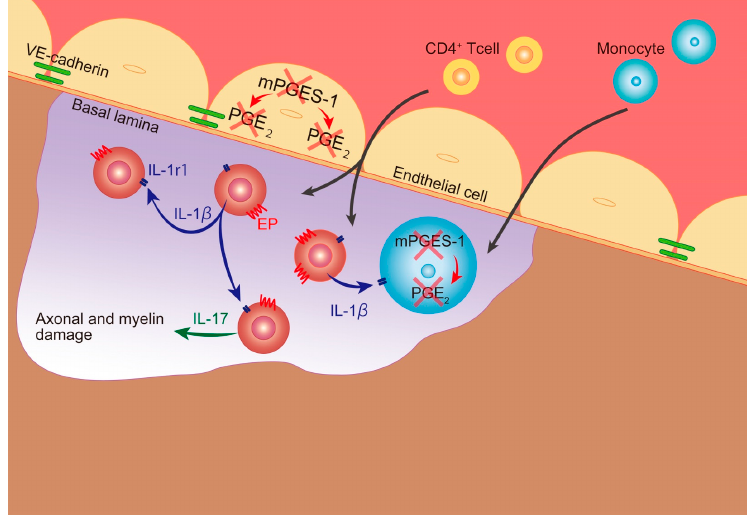
Scheme 2. In contrast, in mPGES-1 − / − mice, CD4 + T cell invasion is suppressed along with EP receptor appearance, and, subsequently, IL-1r1 appearance and the production of IL-1 β and IL-17 are reduced. Red arrows show production and secretion of PGE 2 , blue arrows show IL-1 β , green arrows show IL-17, and gray arrows show cells infiltration from blood to spinal cord.